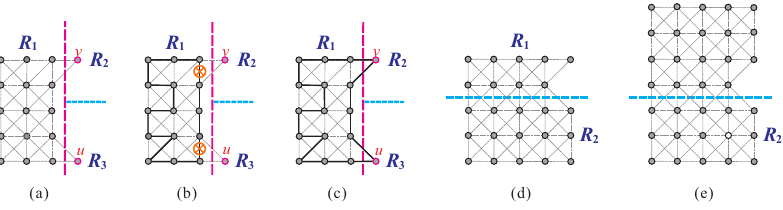
Figure 9. ( a ) A vertical and horizontal separation on C ( m , n ; k , l ; c , d ) , ( b ) a Hamiltonian cycle in R 1 , ( c ) a Hamiltonian cycle in C ( m , n ; k , l ; c , d ) , and ( d , e ) a horizontal separation on C ( m , n ; k , l ; c , d ) , where the bold solid lines indicate the constructed Hamiltonian cycle and ⊗ represents the destruction of an edge while constructing a Hamiltonian cycle.